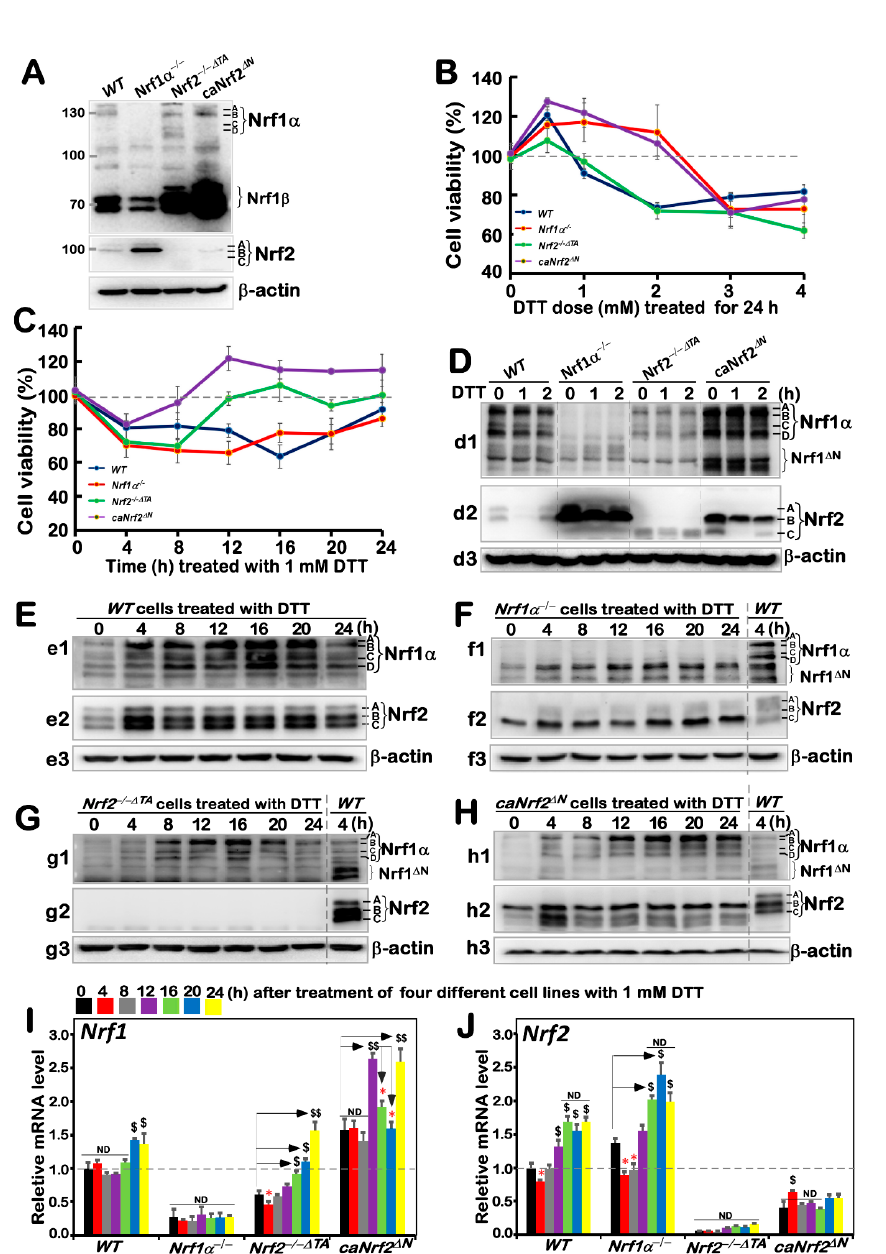
Figure 1. An internal regulatory relationship between Nrf1 and Nrf2 in mediating reductive stress response to DTT. ( A ) Distinct protein levels of Nrf1 and Nrf2 in four different genotypic cell lines WT , Nrf1 α − / − , Nrf2 − / − △ TA and caNrf2 △ N were determined by Western blotting with their specific antibodies. ( B , C ) The viability of these cell lines was detected by the MTT-based assay, after they had been treated with different concentrations of DTT for 24 h ( B ) or treated with 1 mM of DTT for different lengths of time ( C ). ( D – H ) The